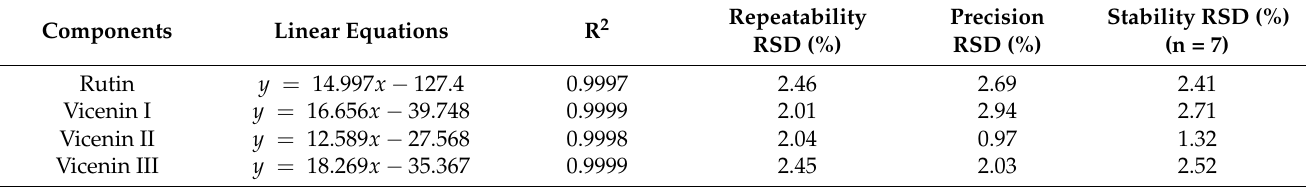
Table 4. Investigation results of the linear relationship of the HPLC methods for four flavonoids.